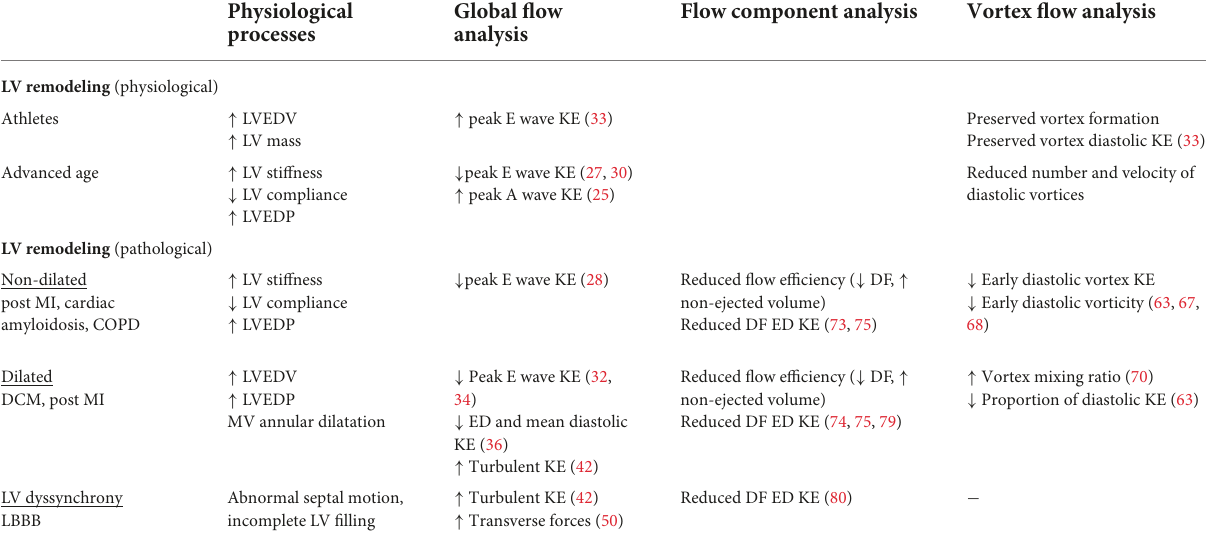
TABLE 6 Cardiac states and associated left ventricular diastolic flow features on 4D flow CMR.